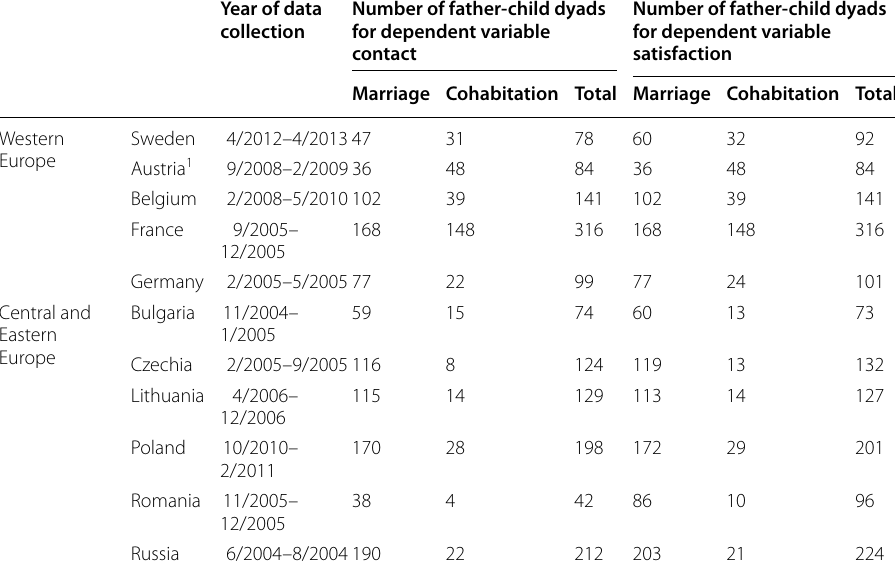
Table 1 Country